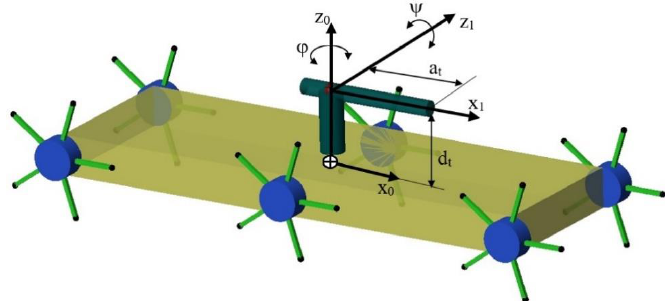
Figure 9. Fire-Extinguishing Ball-Shooting Turret Control System.